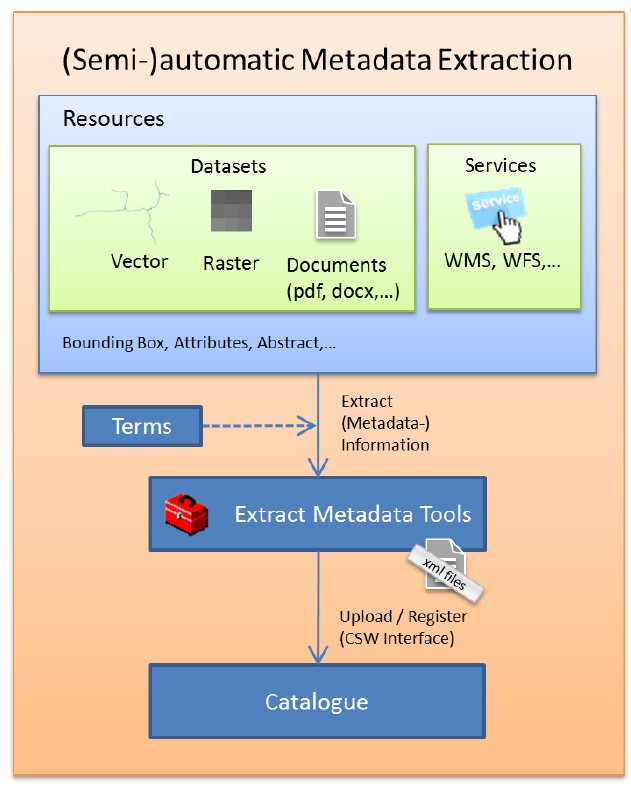
Figure 6. (Semi-)automatic metadata extraction